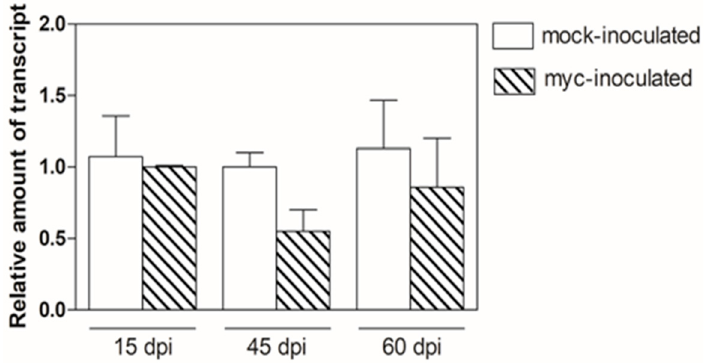
Figure 2. qRT-PCR analysis of MtN5 mRNA level in mycorrhized roots at 15, 45, and 60 dpi calculated versus mock-inoculated roots. Values reported are means ± SE ( n = 3).